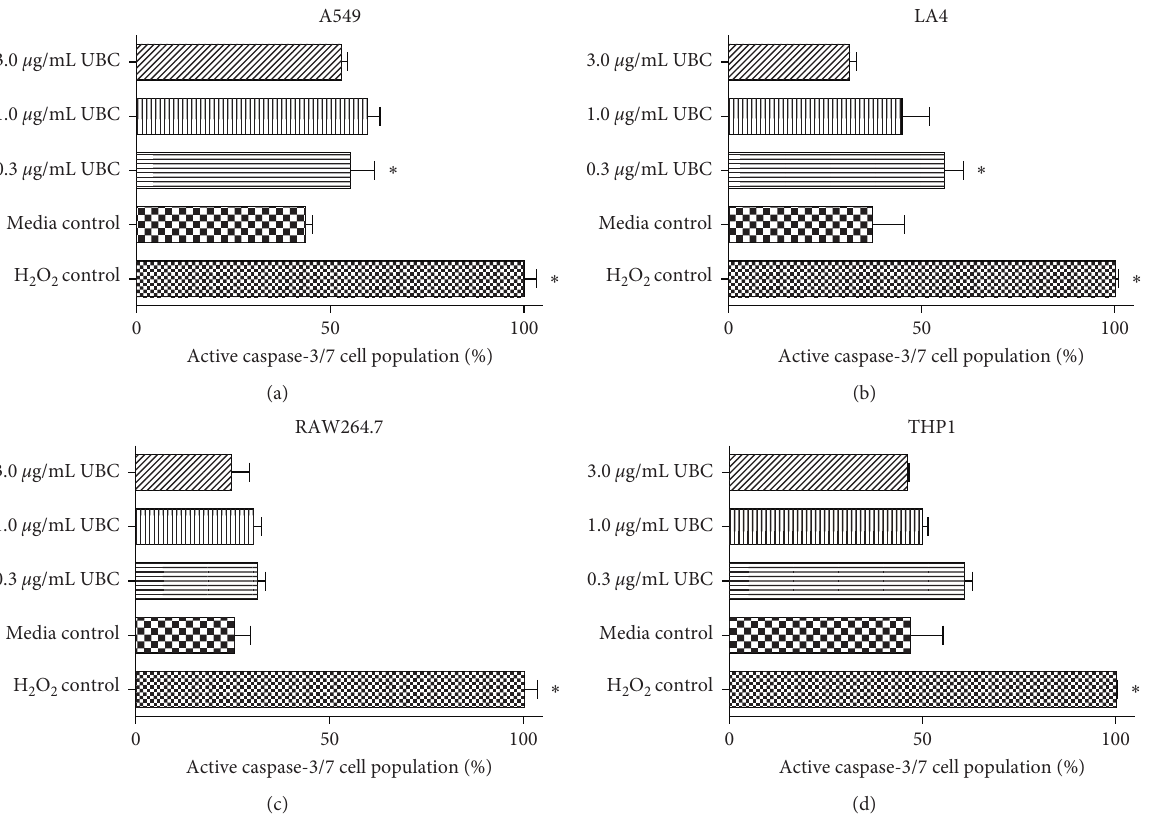
Figure 4: UBC induces little to no apoptosis as measured by caspase-3/7 activity. Cells were UBC-treated as described in Materials and Methods. On day 9, the cells were harvested and stained for active caspase-3/7 for flow cytometric analysis. The data were normalized to the positive control for apoptotic death (hydrogen peroxide-treated cells) for each individual cell line, ((a), (b), (c), and (d)). Data are shown as the mean of two-three duplicates and are representative of three independent experiments. Statistically significant at ∗ p < 0 . 05 in comparison to the untreated